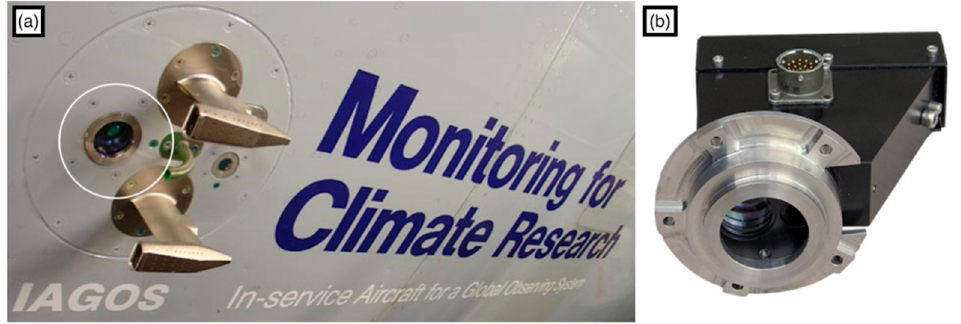
Figure 1. ( a ) Instrument installation on the In-Service Aircraft for a Global Observing System (IAGOS) instrumented Airbus and ( b ) the backscatter cloud probe (BCP).